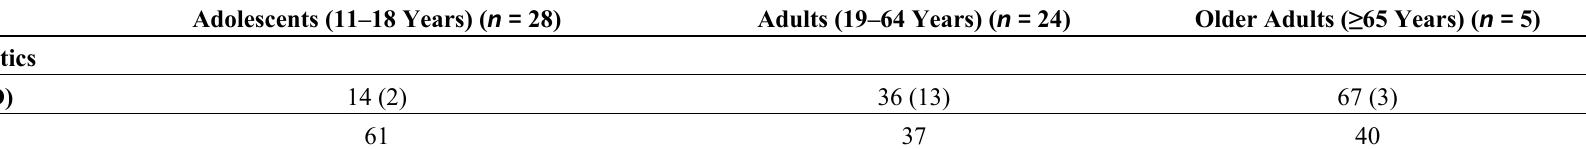
Table 2. Summary of feedback from focus groups on preferred options for an online dietary assessment tool, by age and discussion topic on which views were